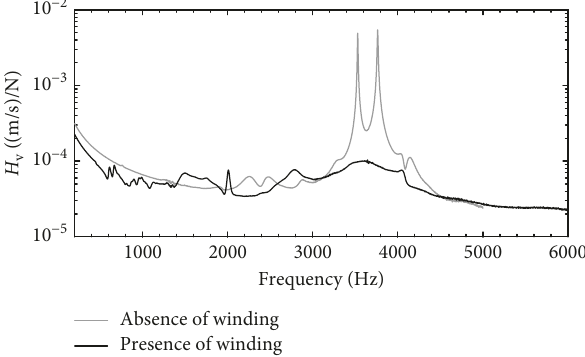
Figure 13: Influence of the winding for the case of radial excitation ( y direction) and measurement of response in the same